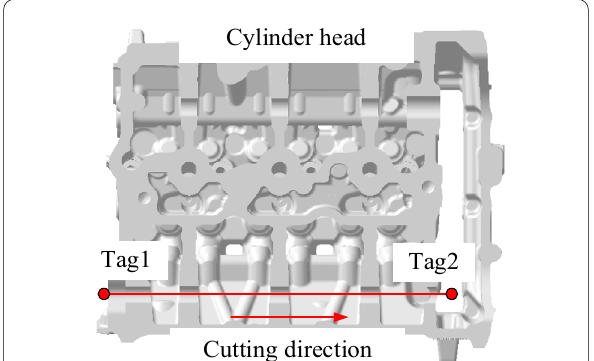
Figure 27 Milling trajectory in the machining task